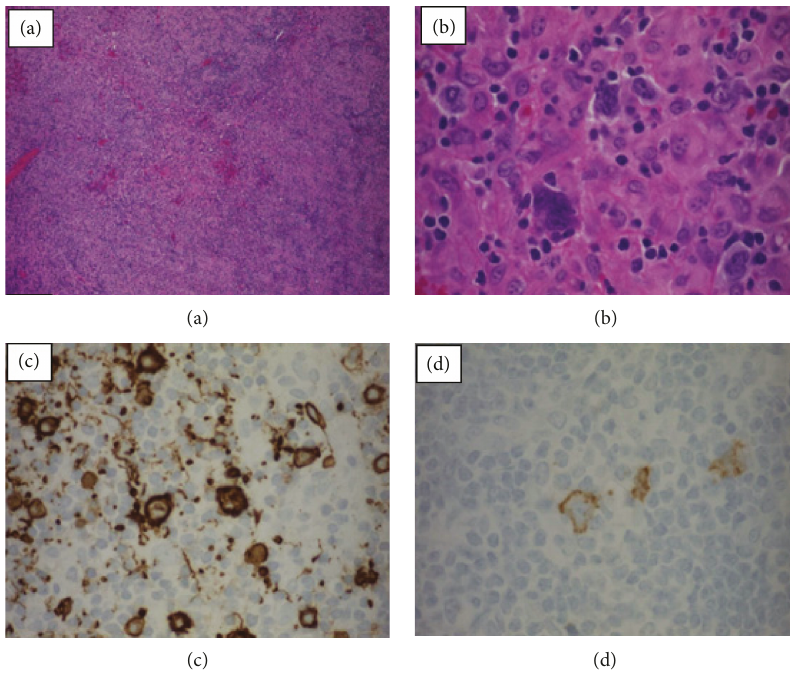
Figure 1: The tissue from the left axillary lymph node biopsy revealed architectural and cytological features consistent with a diagnosis of grey zone lymphoma (GZL). (a) E ff acement of the nodal architecture by scattered large and atypical lymphoid cells with abundant amounts of pale cytoplasm, irregular nuclear contours, vesicular chromatin, and prominent nucleoli. (b) Frequent binucleated and multinucleated forms are also seen. Intermixed are large sheets of histiocytes with abundant cytoplasm. The tissue includes a signi fi cant number of neoplastic cells within the stromal background and includes the broad cytological spectrum with marked nuclear pleomorphism and shows strong presence of atypical lymphocytes. Immunohistochemical stains show that these atypical lymphocyte tumor cells are strongly positive for CD20+ (c) and positive for CD30+